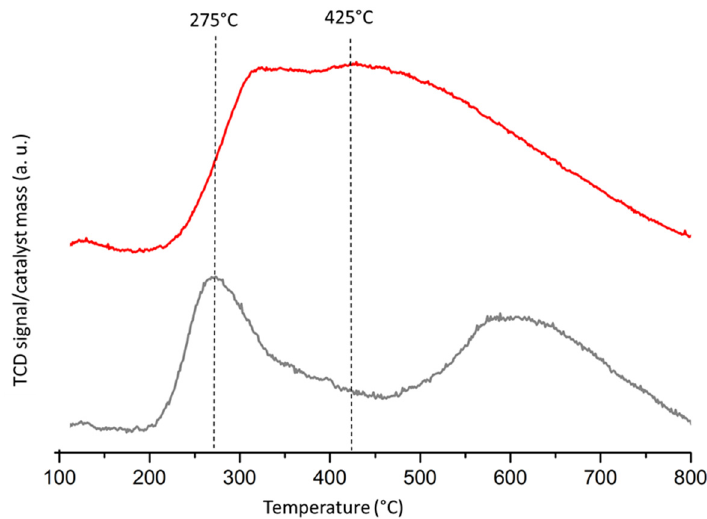
Figure 3. CO 2 -TPD profiles of CsUSY support (in gray) and 3Ru/CsUSY catalyst (in